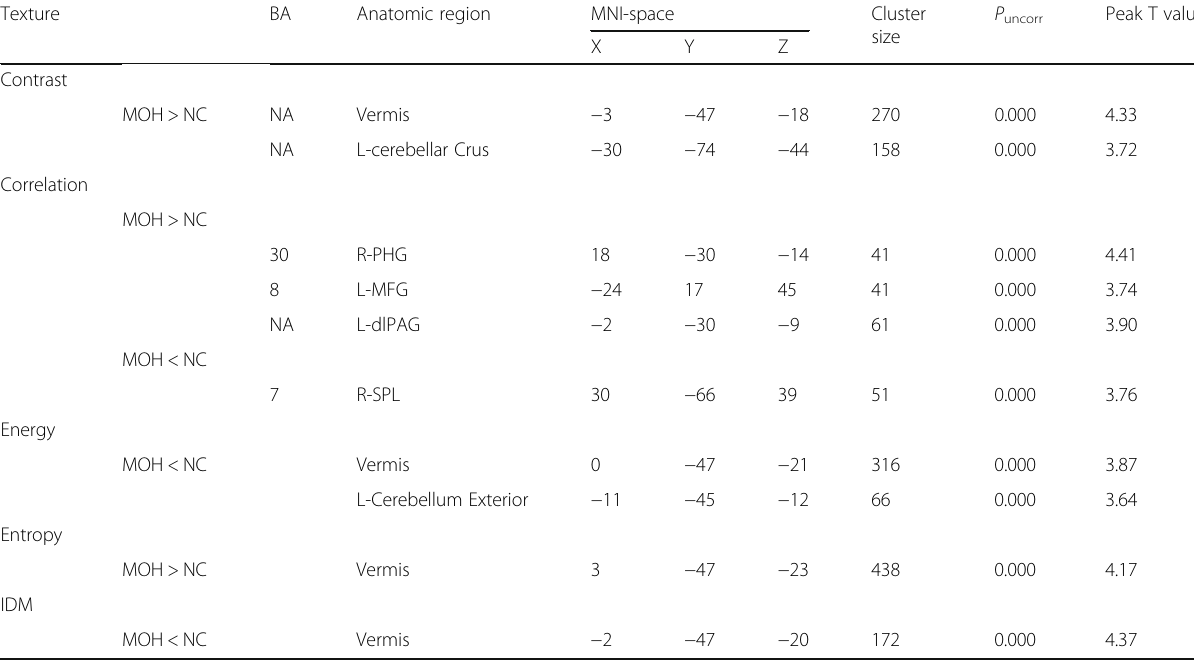
Table 2 The brain regions with altered texture features over the whole brain between MOH and NC Texture